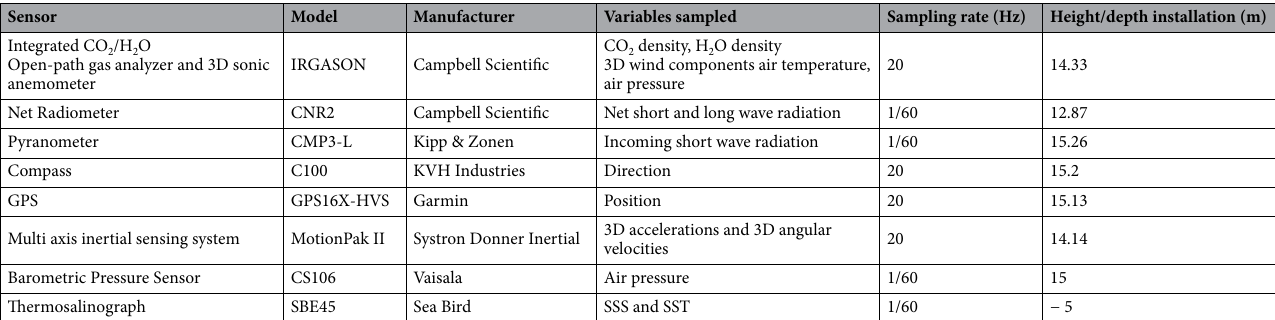
Table 2. Meteorological and oceanic sensors installed on the micrometeorological tower and ship hull during the ATMOS-1